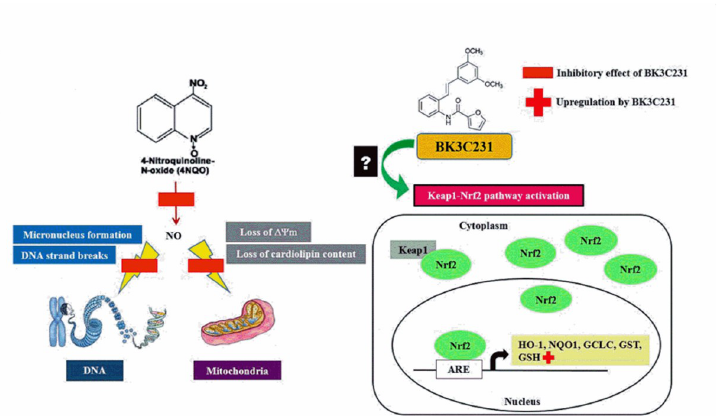
Fig 8. Schematic representation of BK3C231-induced cytoprotection against 4NQO damage in CCD-18Co human colon fibroblast cells. 4NQO caused DNA strand breaks and micronucleus formation as well as mitochondrial membrane potential ( Δ C m) and cardiolipin losses in CCD-18Co cells through NO formation. BK3C231 inhibited these 4NQO-induced DNA and mitochondrial damages by decreasing NO level and increasing GSH level.